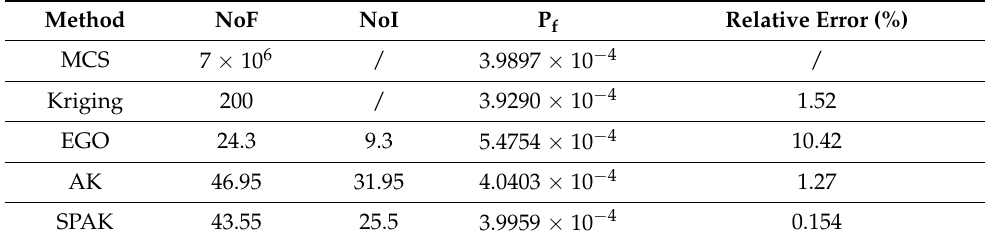
Table 4. Results of different methods for Example 3.